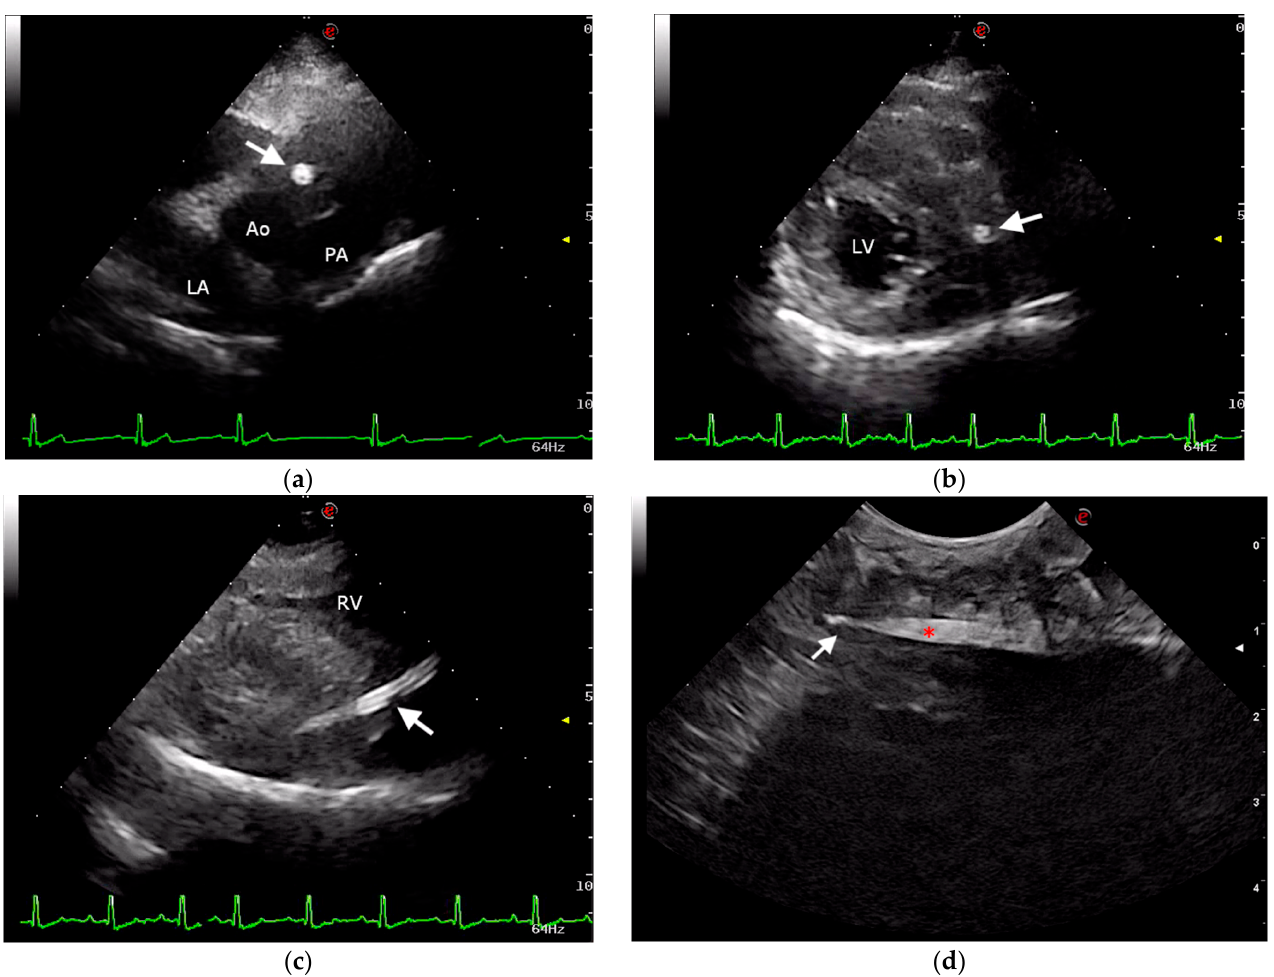
Figure 2. Ultrasonographic images of the intramyocardial porcupine quill. ( a ) Transthoracic echocardiographic image obtained from a right parasternal short-axis view at the level of the heart base showing the foreign body as a circular hyperechoic structure (arrow); ( b ) transthoracic echocardiographic image obtained from a right parasternal short-axis view at the level of the left ventricle showing the foreign body as a circular hyperechoic structure (arrow) with distal acoustic shadowing; ( c ) transthoracic echocardiographic image obtained from a modified right parasternal long-axis view optimized to visualize the foreign body in its longitudinal plane (arrow); ( d ) Intraoperative ultrasonographic image of the tip (arrow) of the quill (red asterisk). Ao, aorta; PA, pulmonary artery;